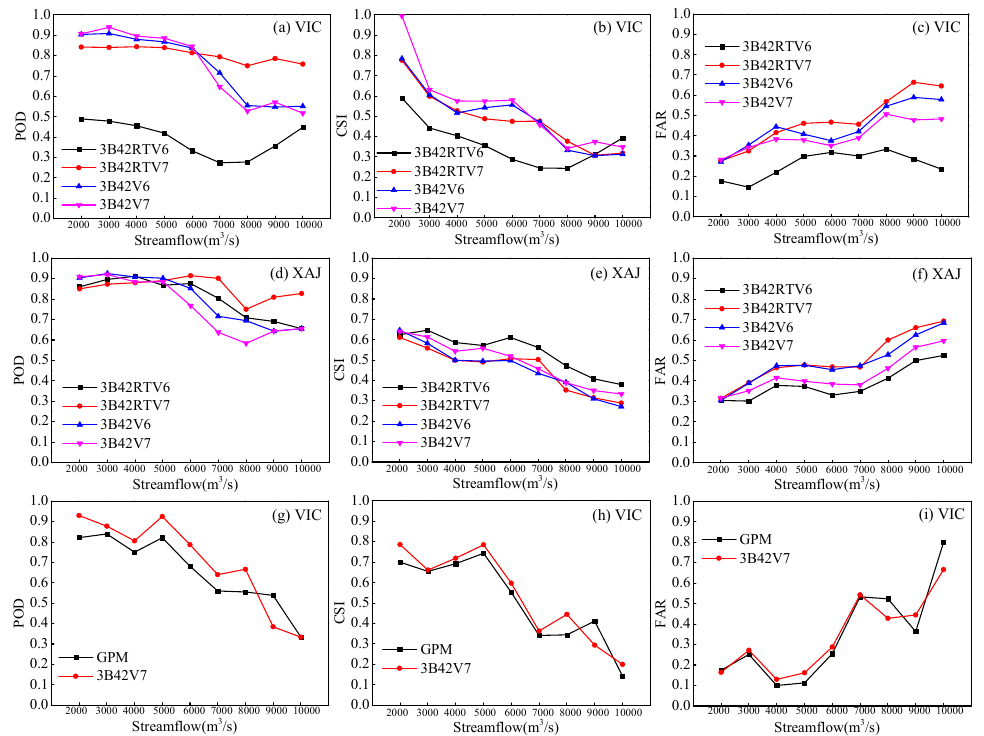
Figure 11. Daily statistical indices for different streamflow thresholds of VIC and XAJ model (a,d,g, POD; b,e,h, CSI and c,f,i, FAR).